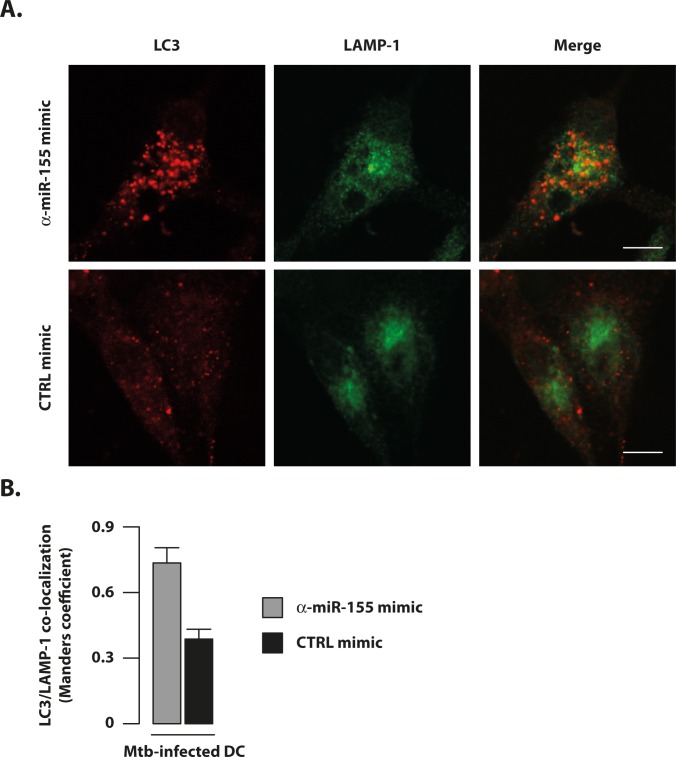
Silencing of miR-155 during Mtb infection recovers DC autophagic flux.DC were infected for 8 hours with Mtb at MOI of 1 bacterium/cell and then transfected with 100 nM of an antagomir oligonucleotides for miR-155 (α-miR155 mimic) or with a negative control mimic (CTRL mimic) for 24 hours. (A) Immunofluorescence analysis of LC3 and LAMP1 in DC infected with Mtb for 8 hours and then transfected with an antagomir oligonucleotides for miR-155 (α -miR155 mimic) or with a negative control mimic (CTRL mimic). Thirty-two hours after infection cells were fixed and then stained with anti-LC3 (red) and anti-LAMP1 (green) antibodies. A representative image for each condition is shown in panel A. Scale bar 15 μm. (B) Graphics reporting a quantification of the experiment described in A and performed as indicated in Material and Methods. The results represent the mean ± standard error of the mean of two independent experiments.